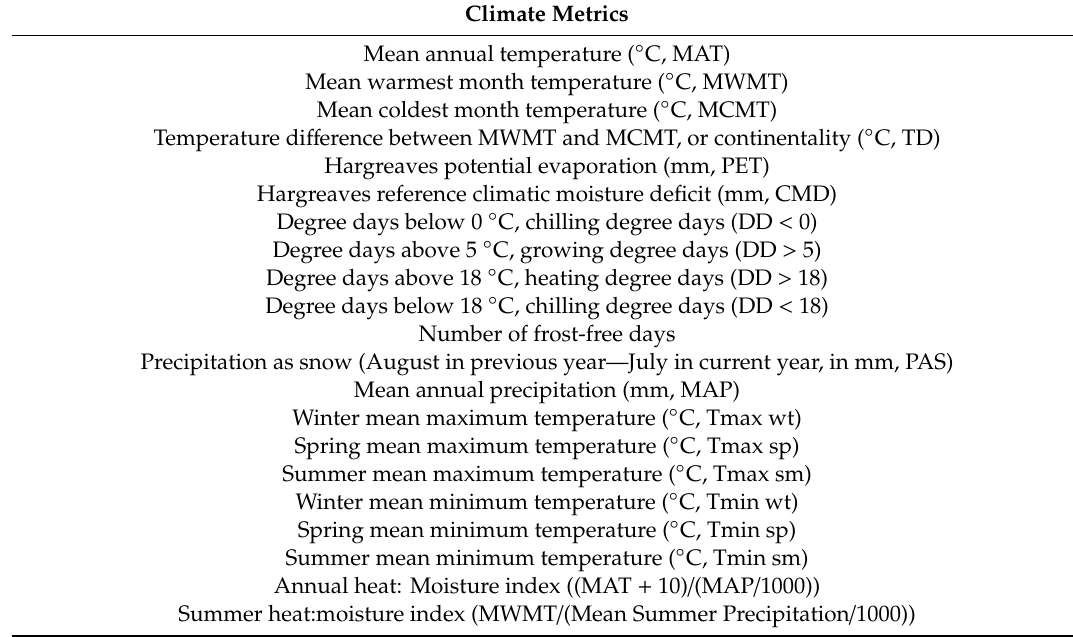
Table 3. Climate metrics analyzed relative to headwater streamflows in Western Oregon, USA